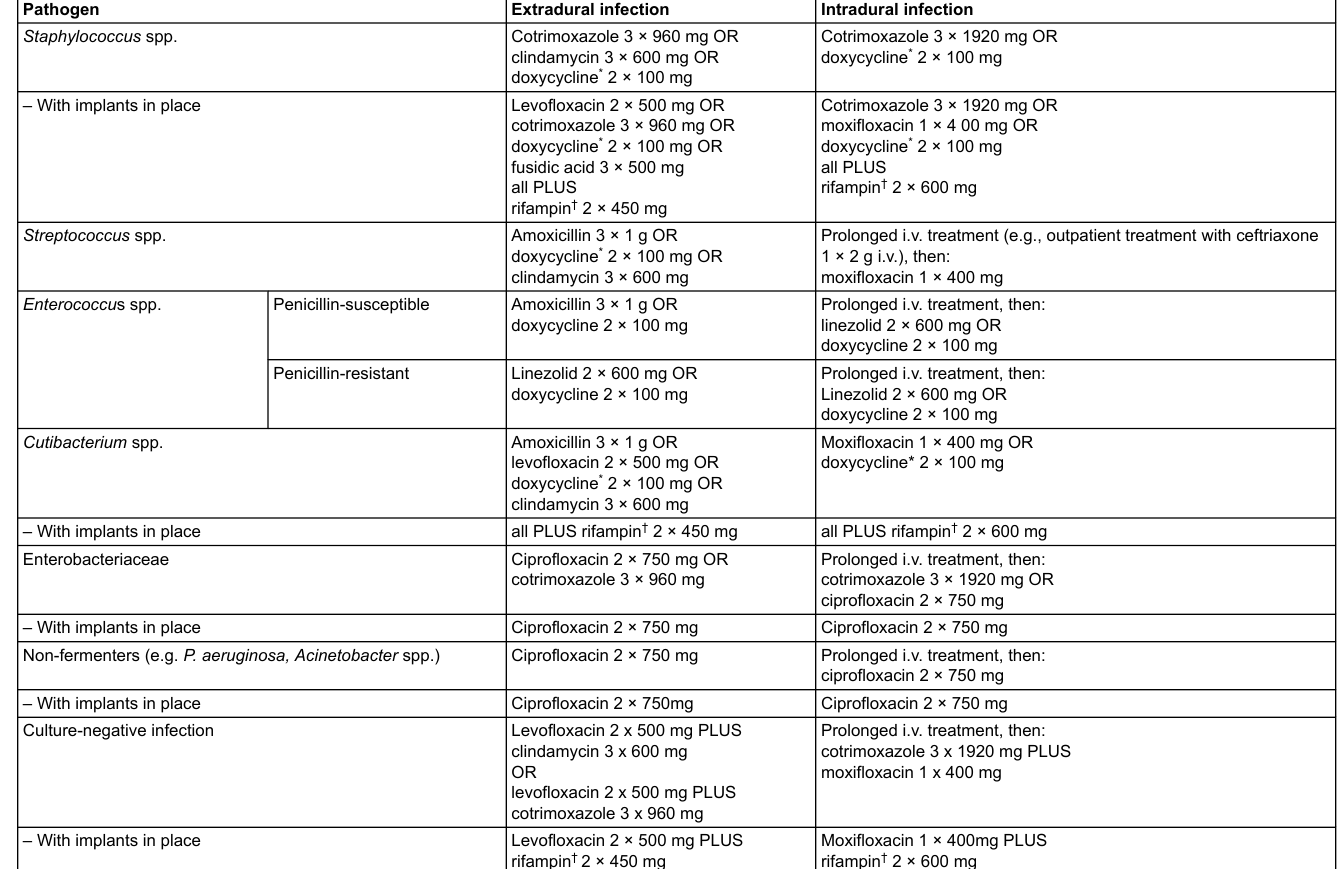
Table 4: Targeted oral treatment for intra- or extradural infections (patient’s renal function and body weight must be taken into account). Rifampin treatment is only indicated if an implant is involved. Pathogen Extradural infection Intradural infection Staphylococcus